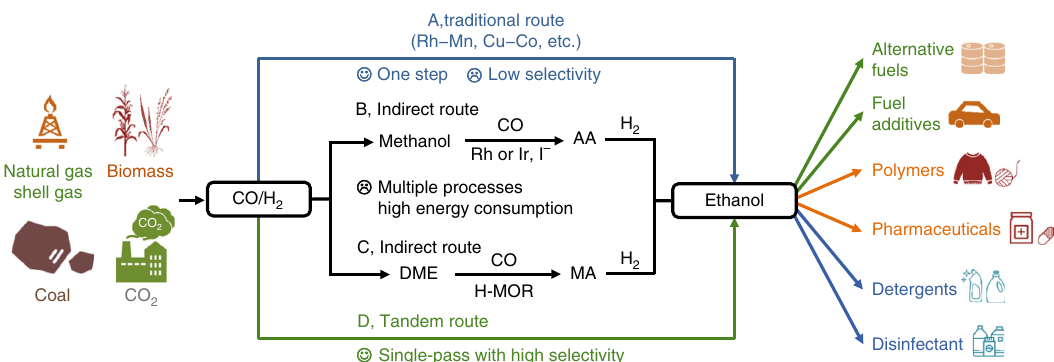
Fig. 1 Routes for conversion of syngas to ethanol. Route A, traditional and direct route based on a single catalyst. Route B, indirect route including three processes, i.e., methanol synthesis, methanol carbonylation with CO and acetic acid (AA) hydrogenation. Route C, indirect route including three processes, i.e., syngas to dimethyl ether (DME), DME carbonylation with CO and methyl acetate (MA) hydrogenation. Route D, Tandem catalytic route of this